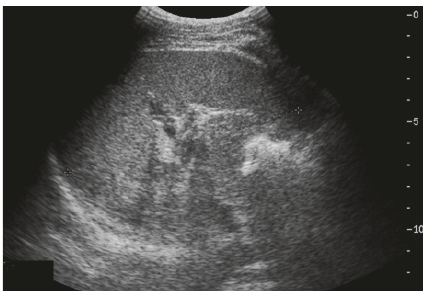
Figure 3: After six months of ATT, ultrasound showed a normal